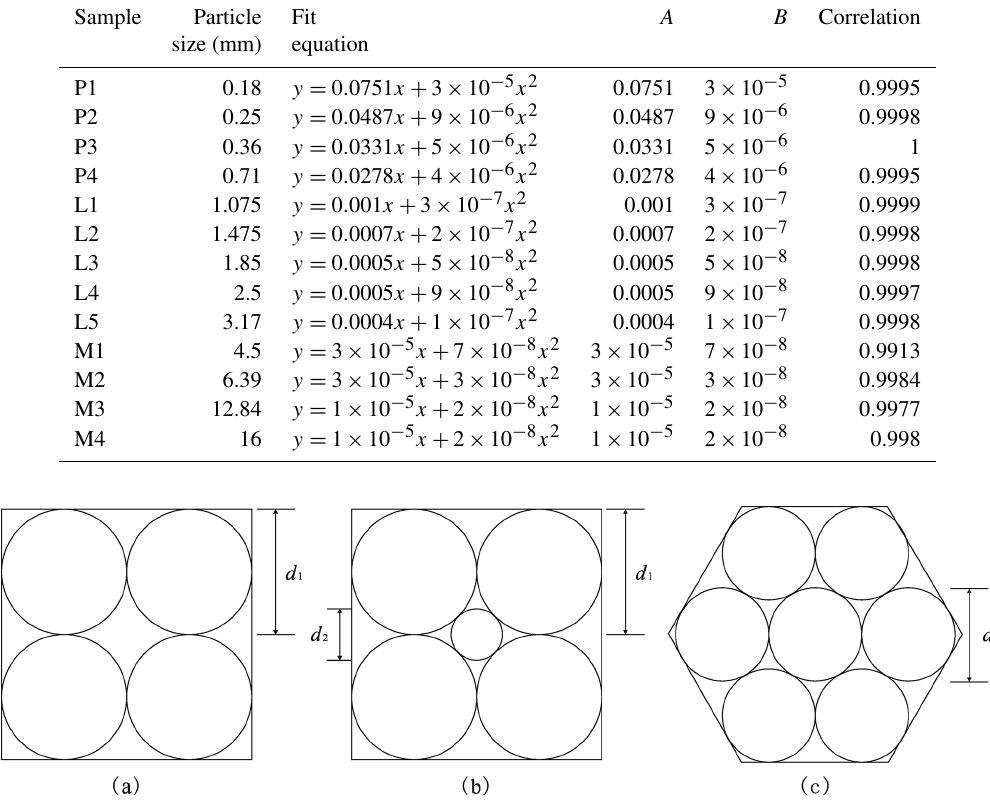
Figure 15. Schematic diagrams of different particle sizes and arrangements: (a) a cubic arrangement with identical solid grains, (b) a cubic arrangement with two different sizes of solid grains, and (c) a hexahedron arrangement with identical solid grains. d 1 is the diameter of each (identical) solid grain in (a) and the diameter of each large solid grain in (b) , d 2 is the diameter of the smaller solid grain in (b) , and d is the diameter of each (identical) solid grain in (c) .